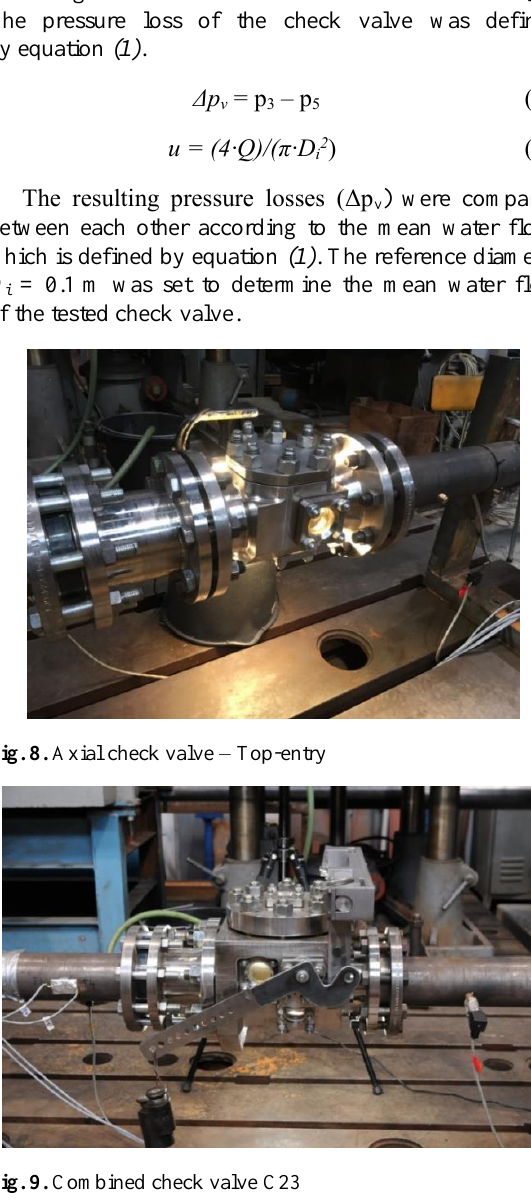
Fig. 9. Combined check valve C23